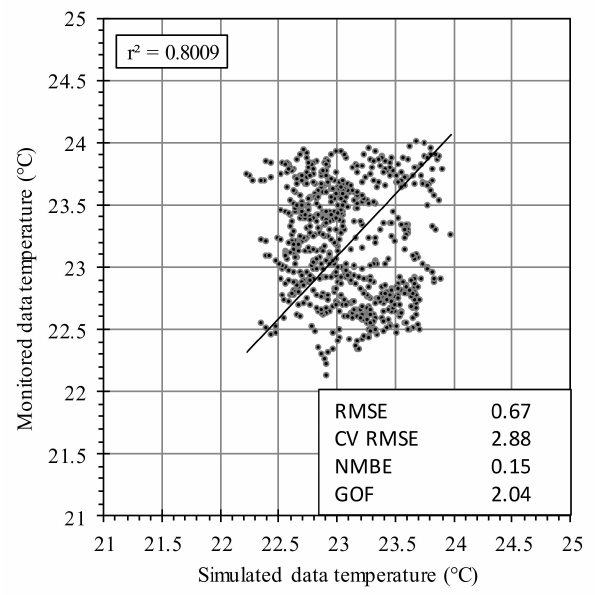
Figure 9. Correlation factor regarding simulated and monitored data.